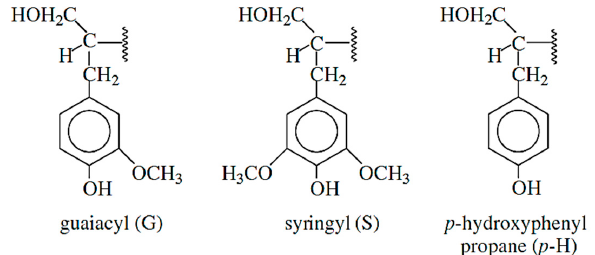
Figure 1. The three structural units of lignin [25], reproduced with permission from Elsevier.